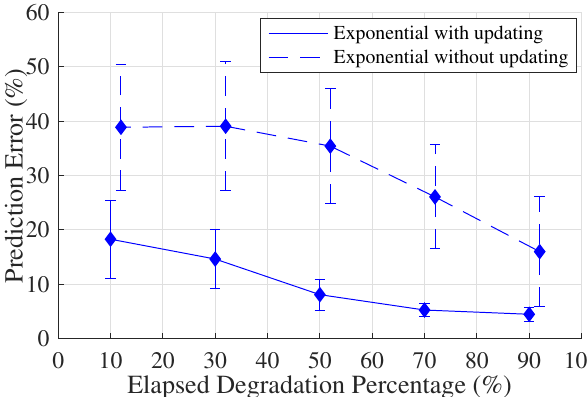
Figure 8. A comparison between the ‘exponential without updating model’ and the ‘exponential with updating model’ regarding residual life prediction